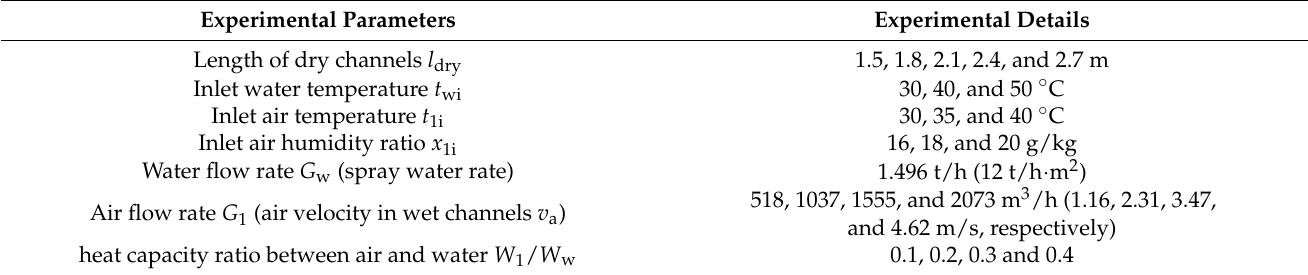
Table 2. Details of experimental